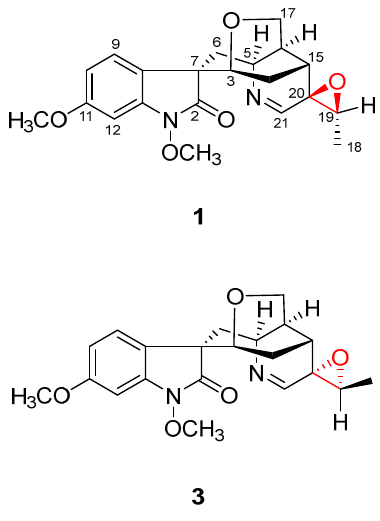
Figure 1. Structures of compounds 1–3